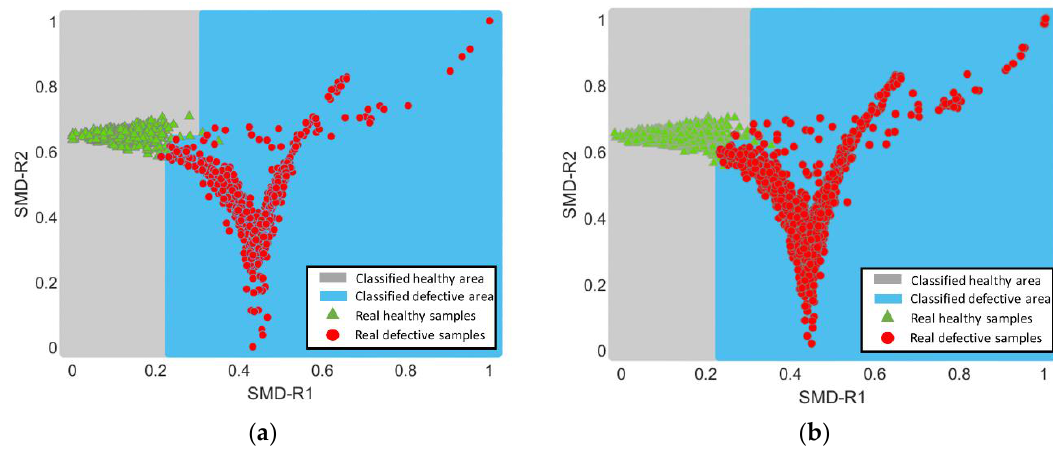
Figure 14. ( a ) Classification on the training dataset; ( b ) classification on the testing dataset.